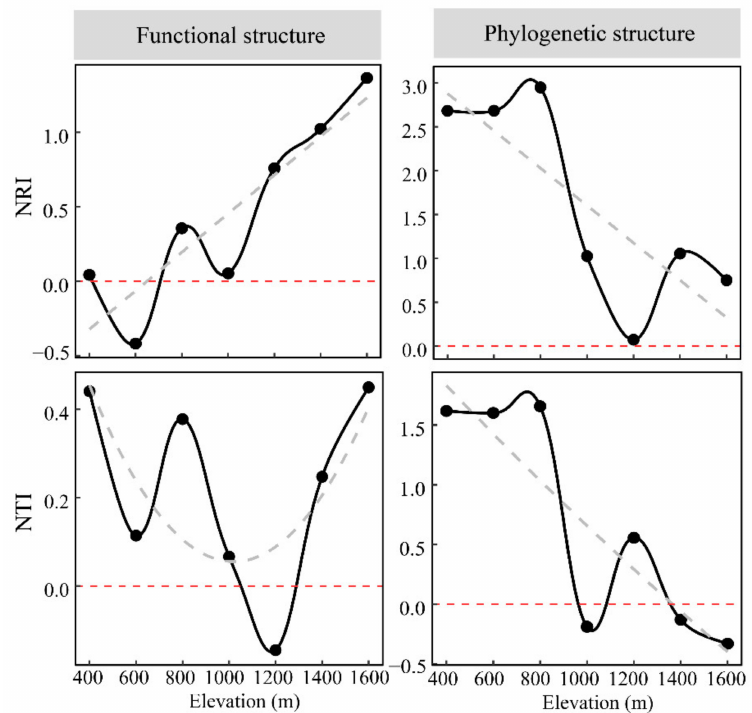
Figure 5. The patterns of phylogenetic and functional structure of small mammal communities along the elevational gradients in Qingliang Mountain. The gray dashed line represents the best-fit